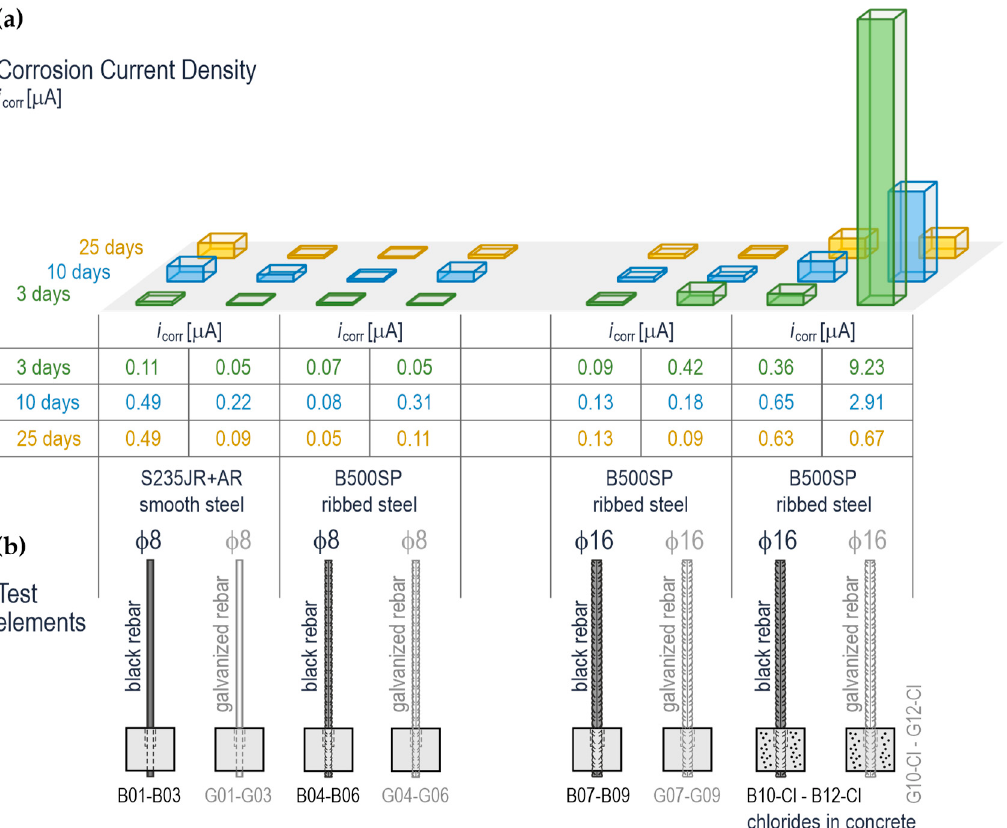
Figure 10. The results from electrochemical tests on reinforcing steel in concrete on days 3, 10, and 25 from setting the specimens in concrete: ( a ) corrosion current density i corr determined with the LPR technique, ( b ) the test elements with galvanized and black reinforcing steel (smooth φ 8 mm and ribbed φ 8 and φ 16 mm) in concrete with and without